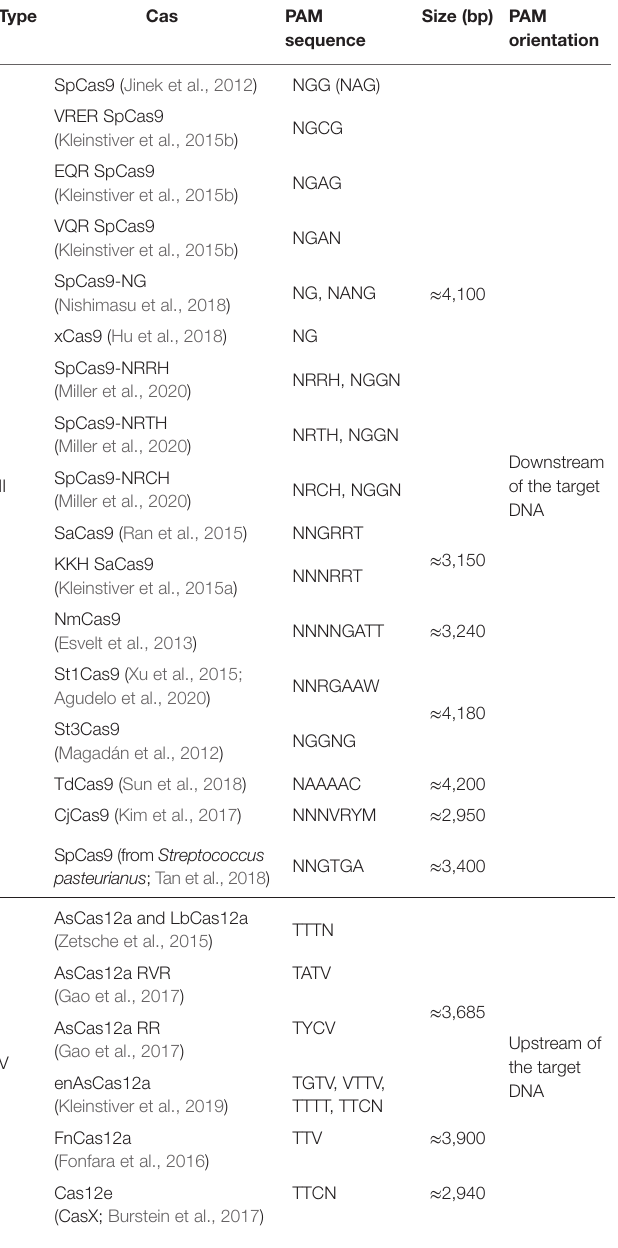
TABLE 1 | Cas diversity and